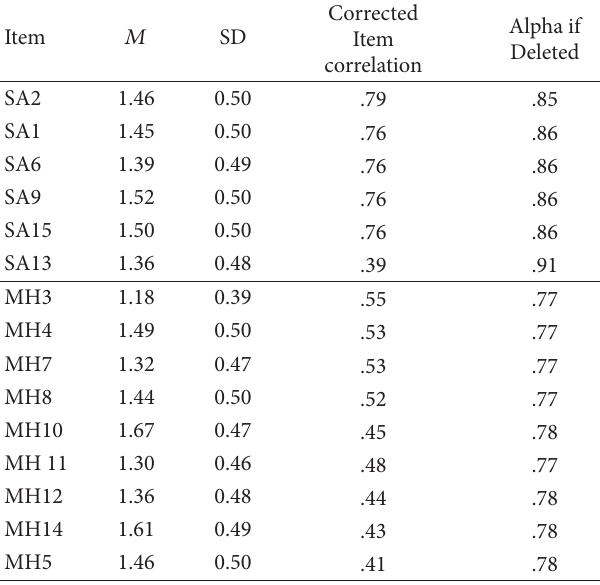
T 2: Descriptive statistics and item analysis for the 15-item AC- OK Co-occurring screen ( N =